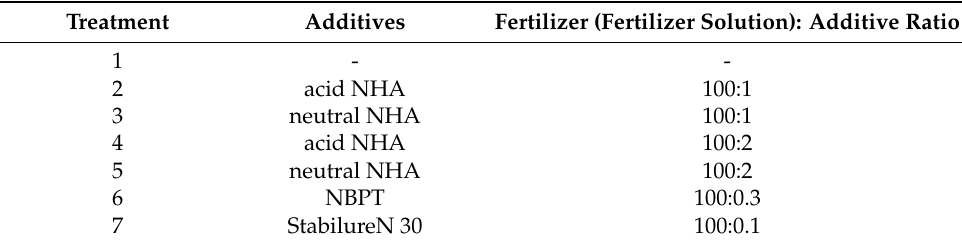
Table 4. Examined treatments repeated for UAN and each fertilizer solution.